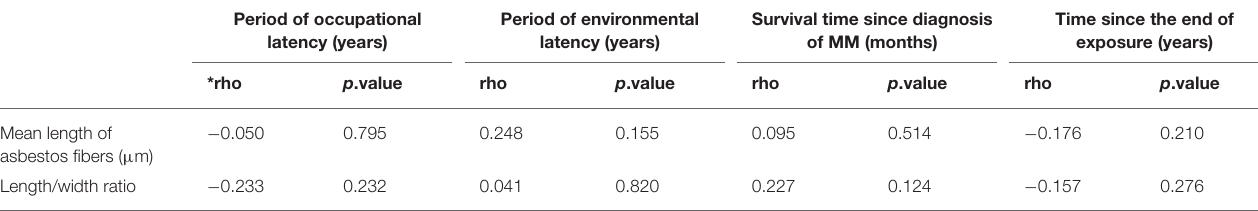
TABLE 3 | Spearman’s rank correlation coefficients of correlation between mean length, length/width ratio, and the chronologic variables considered. Period of occupational Period of environmental Survival time since diagnosis Time since the end of latency (years) latency (years) of MM (months) exposure (years) *rho p .value rho p .value rho p .value rho p